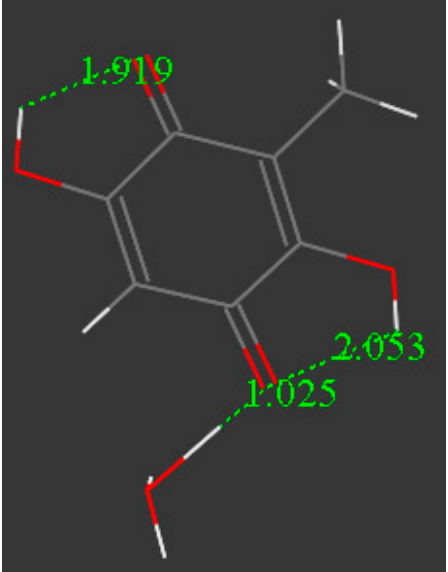
Figure 7. After superoxide donates the electron to the embelin-model ring, H 3 O + is reacted at one